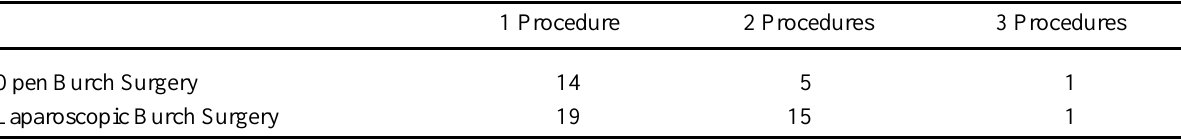
Table 2 – Number of surgical procedures associated with Burch